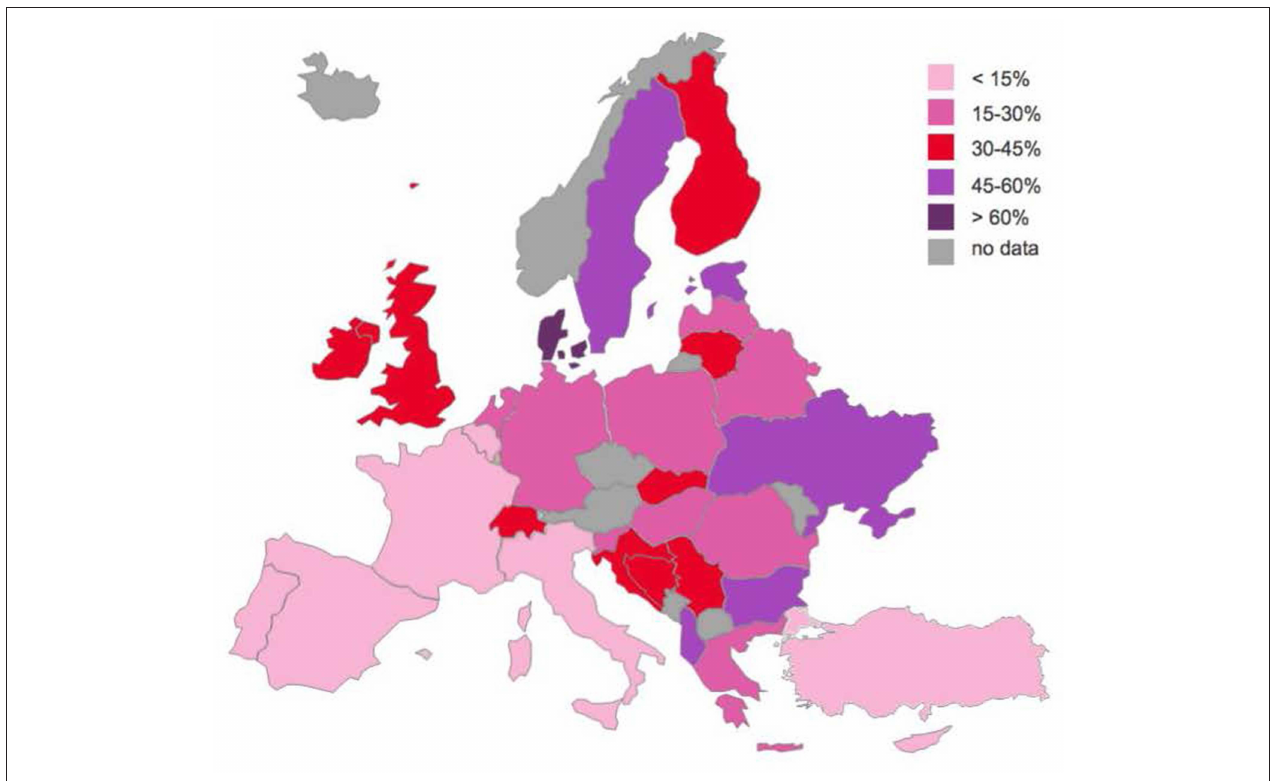
FIGURE 2 | Psychiatric trainees who are parents.